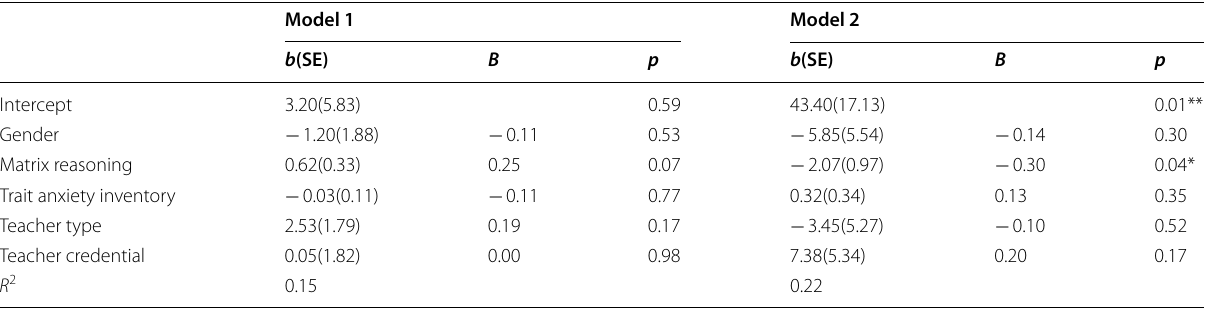
B are standardized betas. Numbers in parentheses are standard errors. The outcome variable for Model 1 was Mental Rotation score. The outcome variable for Model 2 was teachers’ Spatial Anxiety Scale score * p < 0.05, ** p <